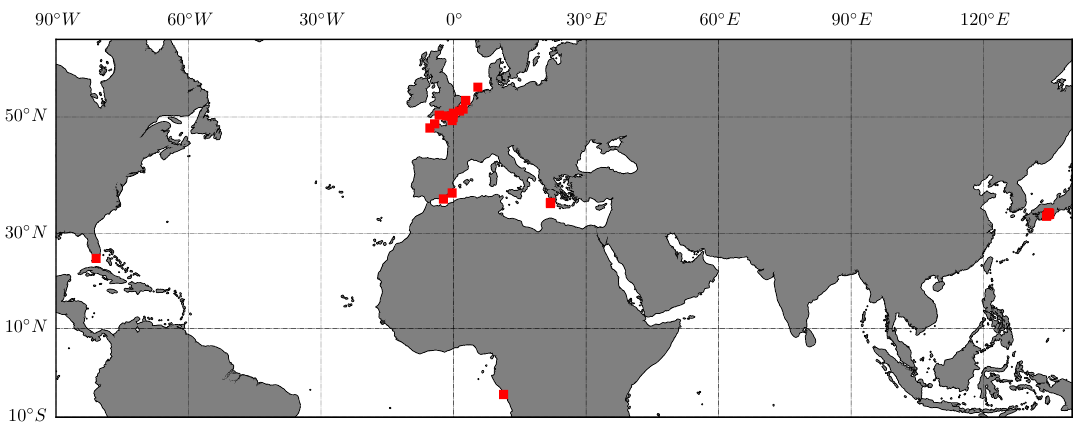
Figure 9. Map of buoys used for salinity and temperature extrapolation.